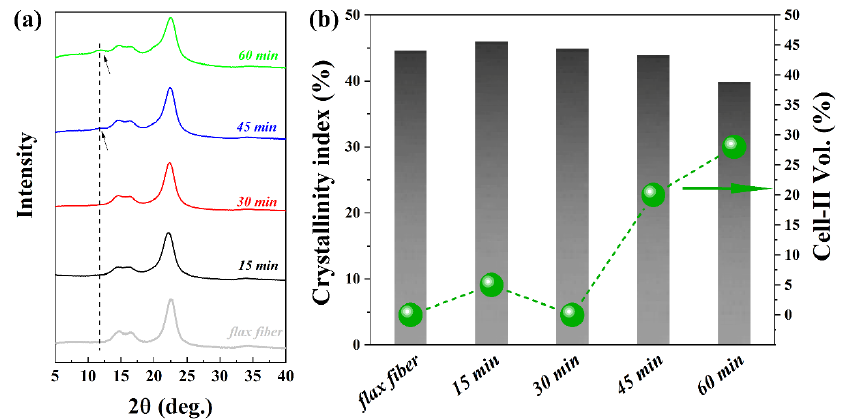
Figure 6. ( a ) X-ray diffractograms of flax fibers and ACC (the arrow shows the appearance of cellulose II) and ( b ) total crystallinity and volume fraction of cellulose II in ACCs as a function of impregnation time.